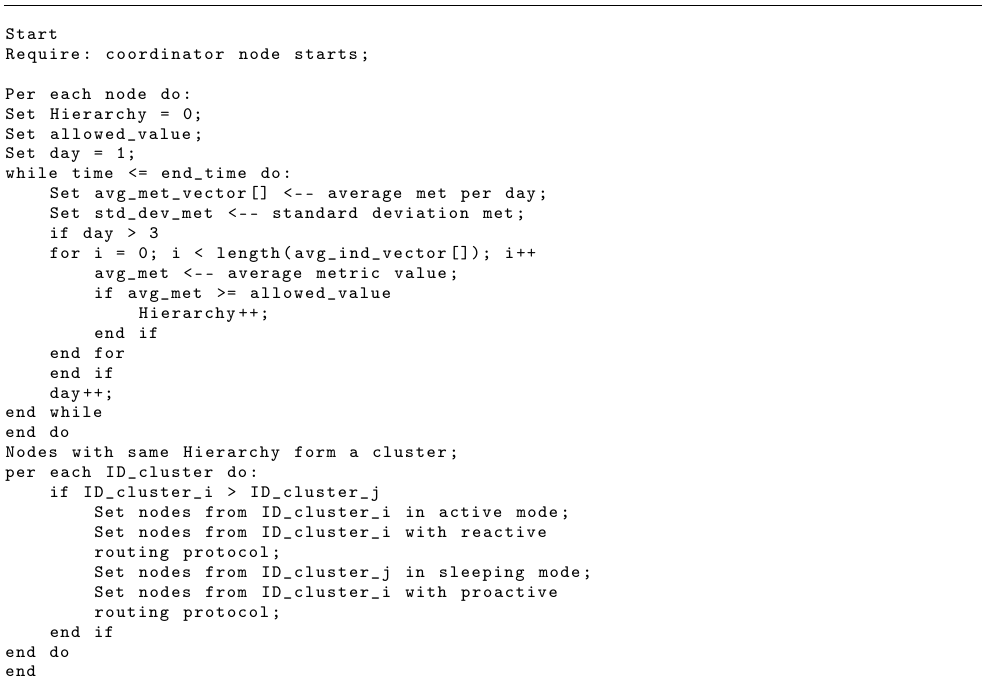
Algorithm 1 Pseudocode of the